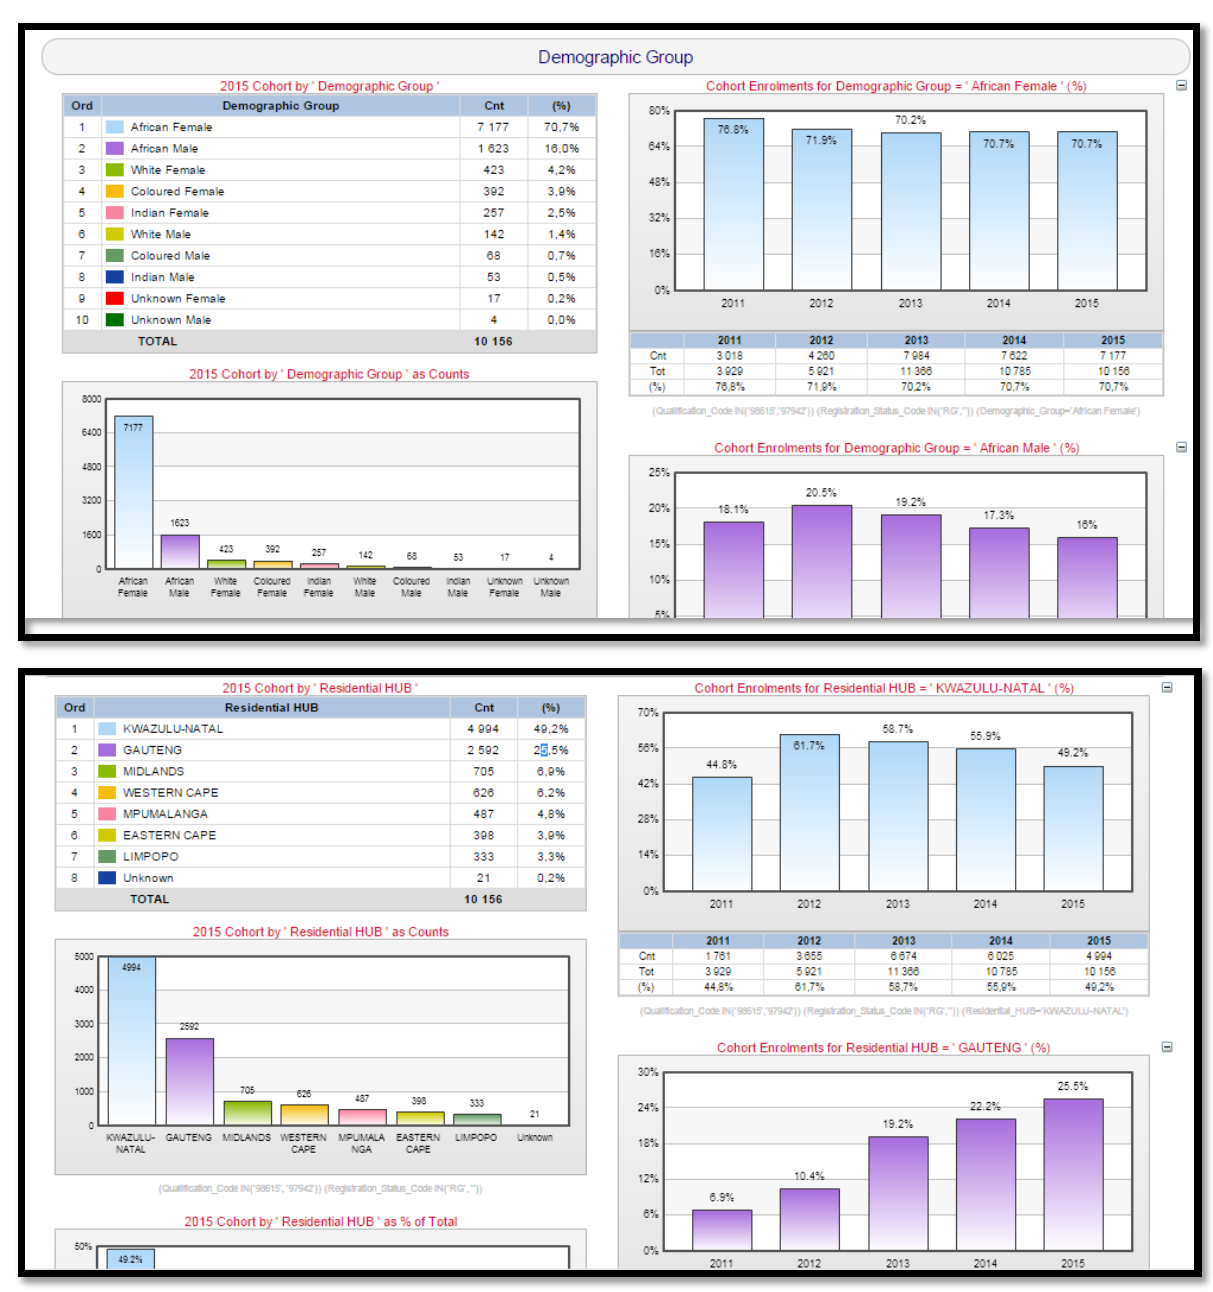
Figure 11 . Excerpts cohort